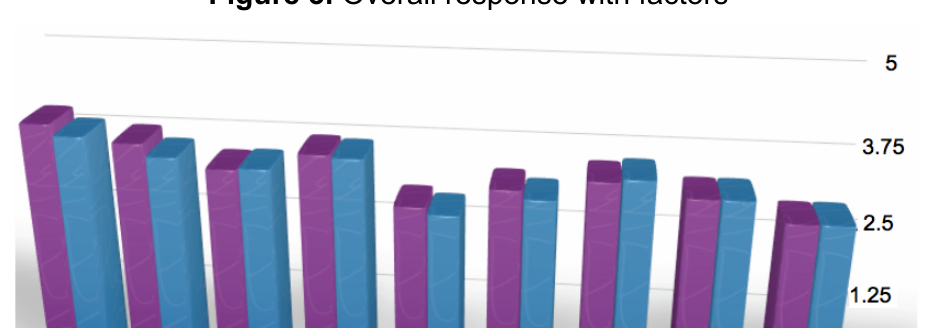
Figure 3. Overall response with factors